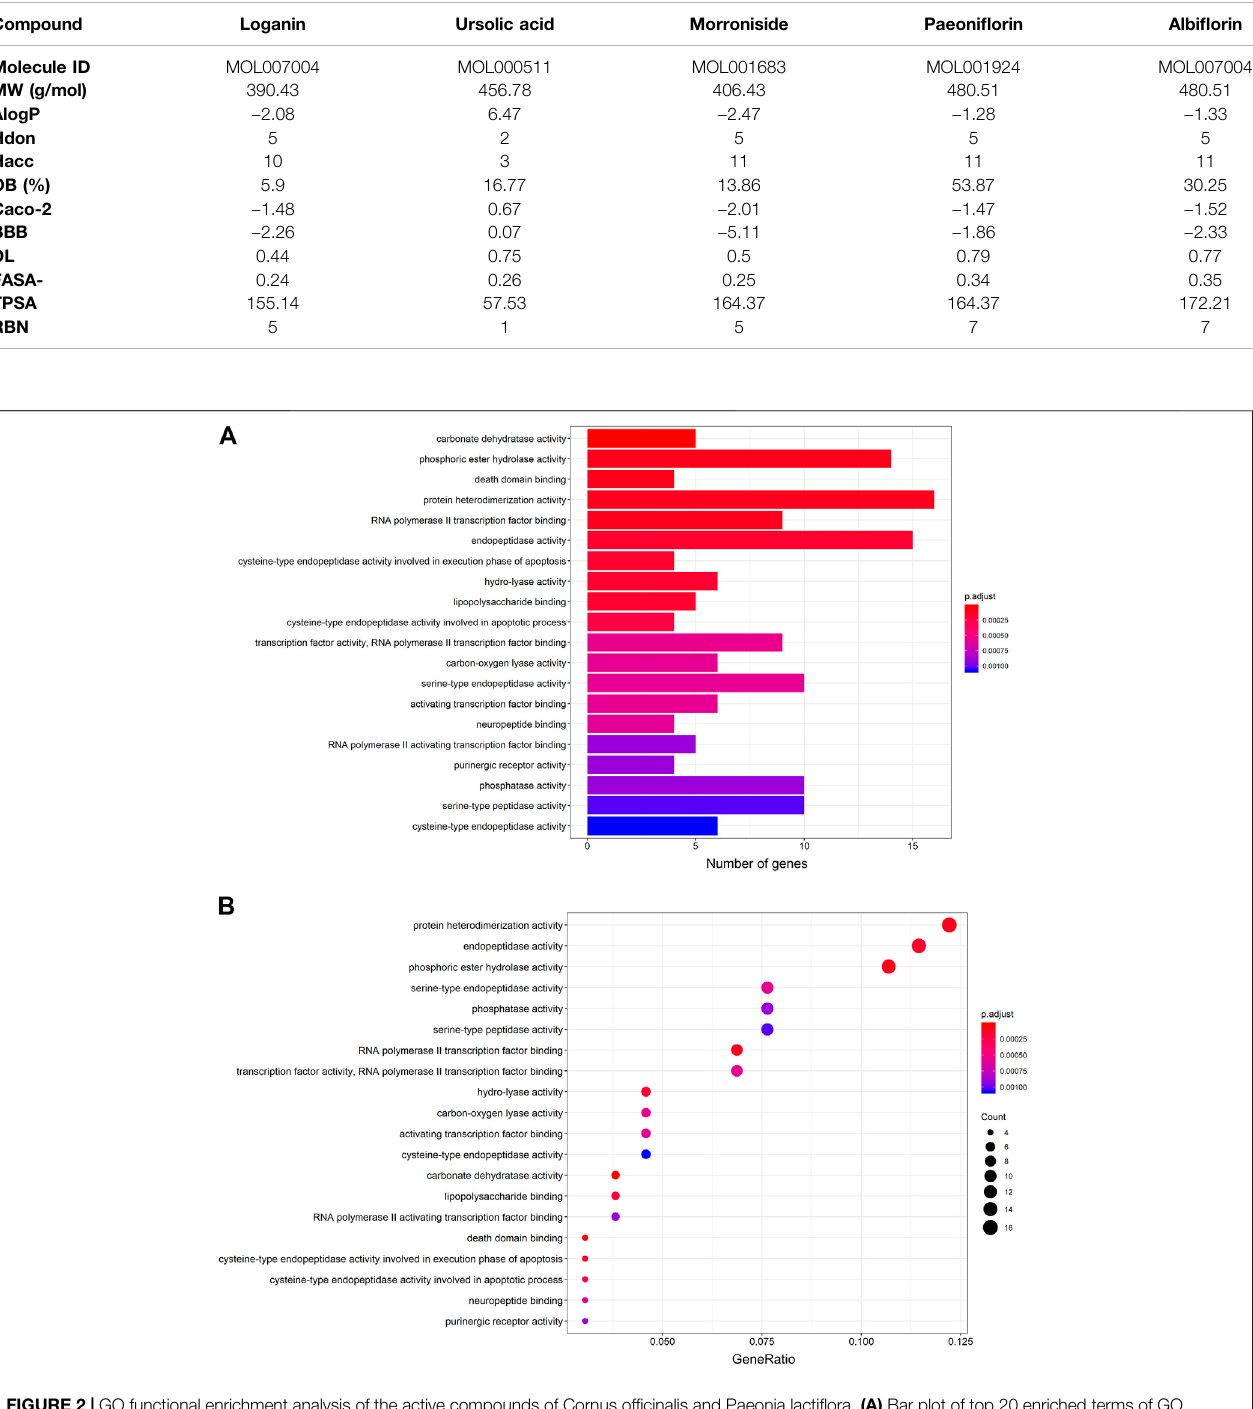
FIGURE 2 | GO functional enrichment analysis of the active compounds of Cornus of fi cinalis and Paeonia lacti fl ora. (A) Bar plot of top 20 enriched terms of GO functional analysis, ranked by enrichment score. The intensity of the colors represents the adjusted p -value. (B) Bubble plot displaying the top 20 enriched terms of GO functional analysis, ranked by gene count. The intensity of the colors represents the adjusted p -value and the bubble size corresponds to the number of genes.